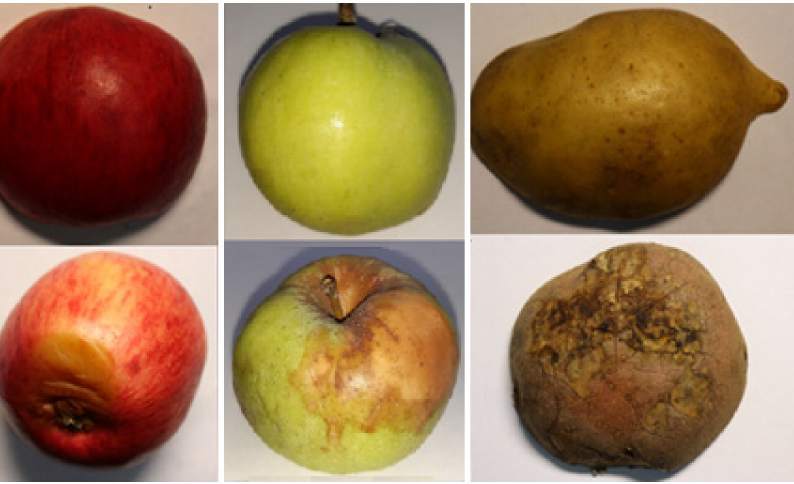
Figure 4. Apples and potatoes used in experiments with pulsed fluorescence spectroscopy. Healthy ( top ) and rotten ( bottom )